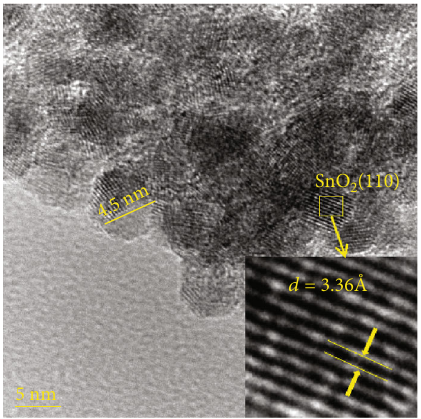
Figure 6: TEM image of 5% Zn-SnO